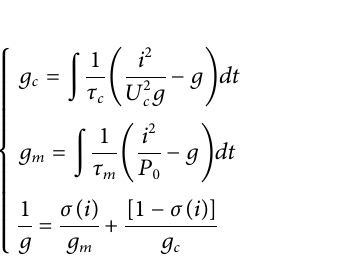
Frontiers in Energy Research |